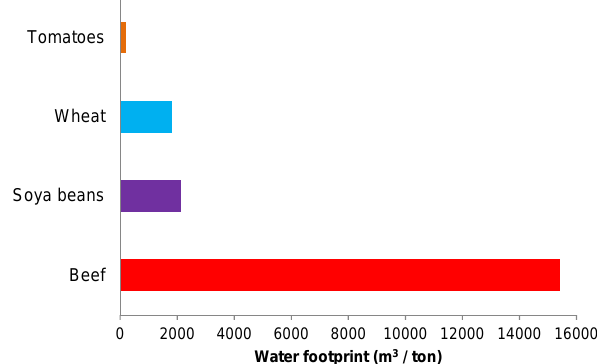
Figure 1. The water footprint of selected agricultural products. Data source: Mekonnen and Hoekstra (2012a). Note that these are average global values which show considerable variability from place to place depending on climate and agricultural efficiency (Hoekstra and Chapagain, 2008).